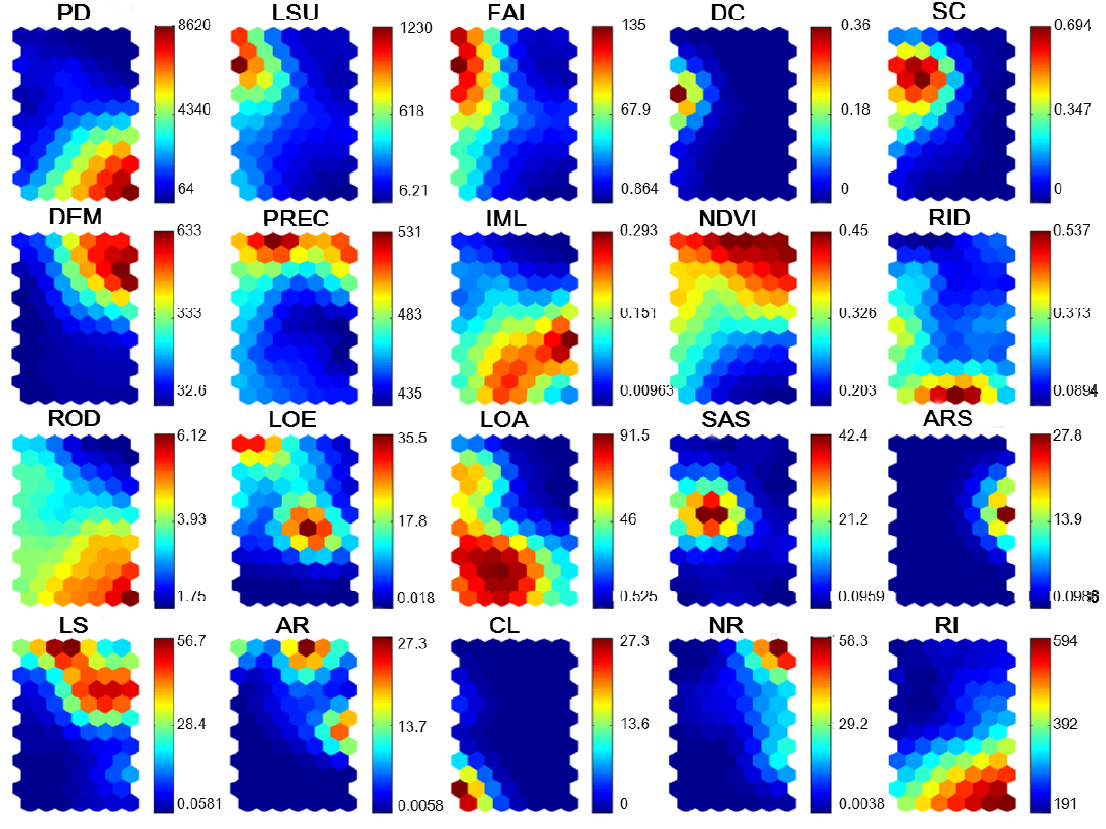
Figure 6. Component maps of the SOM model. The name of each panel represents the input parameters shown as the above. The information of parameter name abbreviation can be found in Table